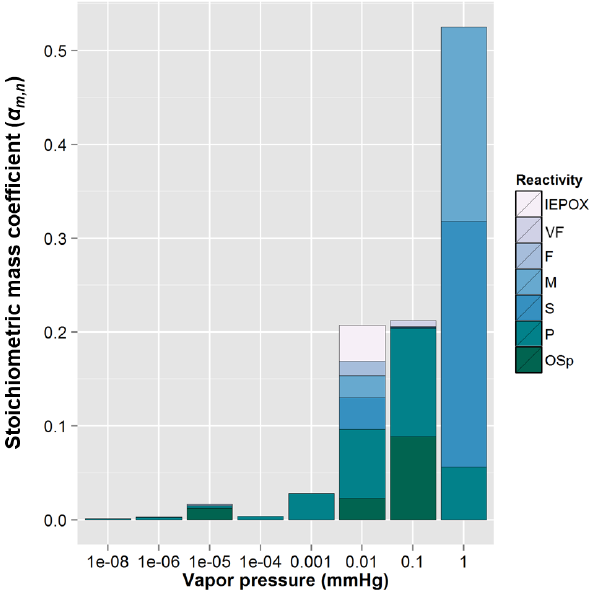
Figure 2. The stoichiometric mass coefficients ( α i ) of each lump- ing group at a VOC / NO x (ppbCppb − 1 ) of 25. The photooxida- tion products predicted by an explicit gas phase chemical mecha- nism are lumped as a function of vapor pressure ( x axis, eight bins) and aerosol phase reactivity ( y axis, six bins). The aerosol phase reactivity bins are very fast (VF, α -hydroxybicarbonyls and tricar- bonyls), fast (F, 2 epoxides or aldehydes,), medium (M, 1 epoxide or aldehyde), slow (S, ketones), partitioning only (P), organosulfate precursors (OS P , 3 or more alcohols) and IEPOX products, which were lumped separately to more easily quantify their